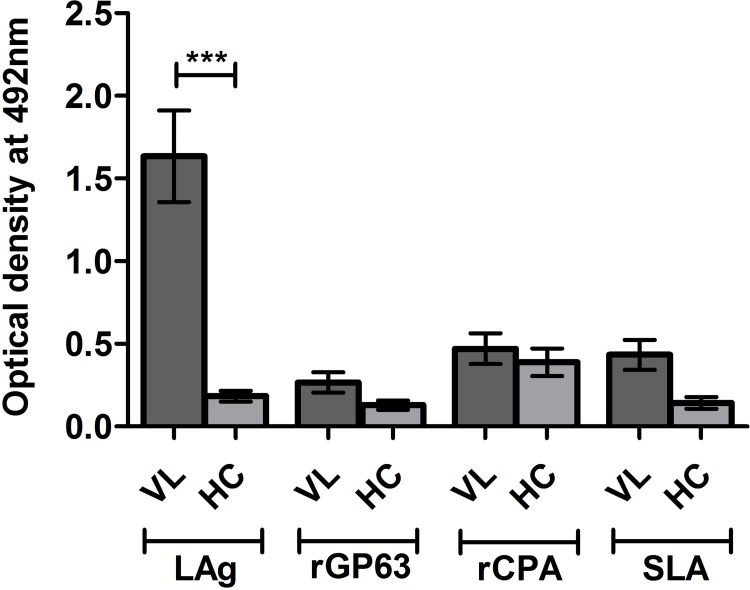
Comparison of urine antibody absorbances between VL patients and healthy controls using four leishmanial antigens.Reactivity of urine (undiluted) from visceral leishmaniasis (VL) patients (n = 5) and healthy controls (HC) (n = 6) against 2.5 μg/well of leishmanial membrane antigen, LAg; recombinant glycoprotein 63, rGP63; recombinant cysteine protease A, rCPA and soluble leishmanial antigen, SLA. The standard error of mean for each group is shown as a solid line.